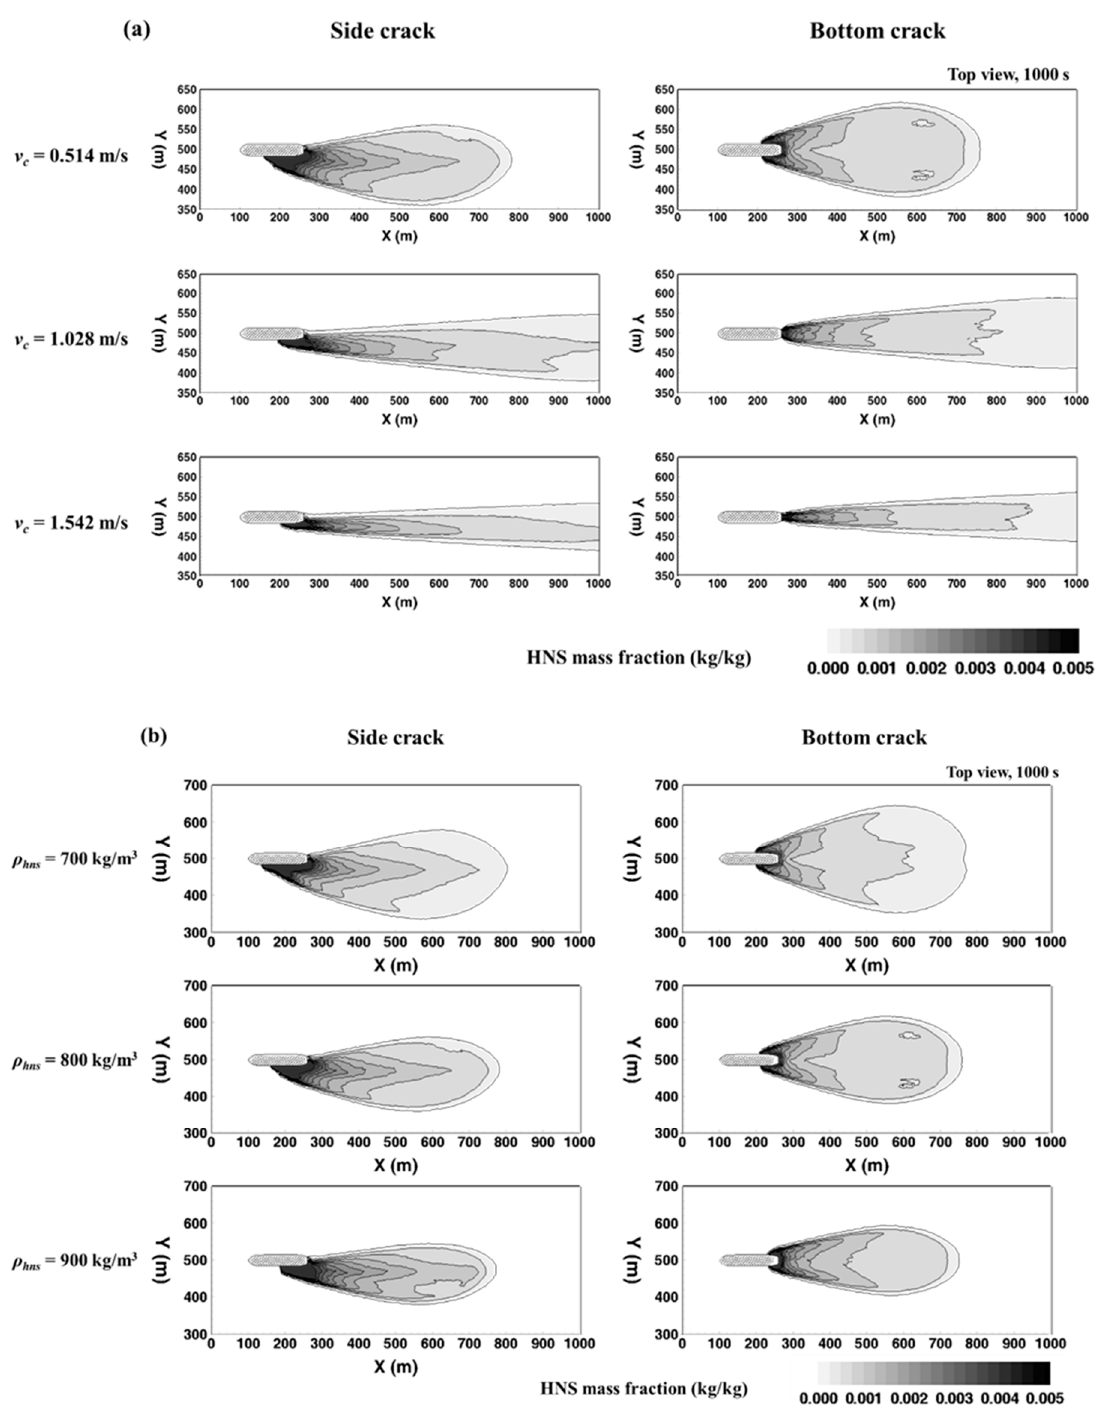
Figure 3. HNS propagation HNS behavior obtained by ( a ) different current velocity with ρ hns = 800 = 0.514 m / s, according to crack location at 1000 kg/m 3 and ( b ) different HNS density with v c = 0.514 m/s, according to crack location at 1000 s. 800 kg / m 3 and ( b ) di ff erent HNS density with v c